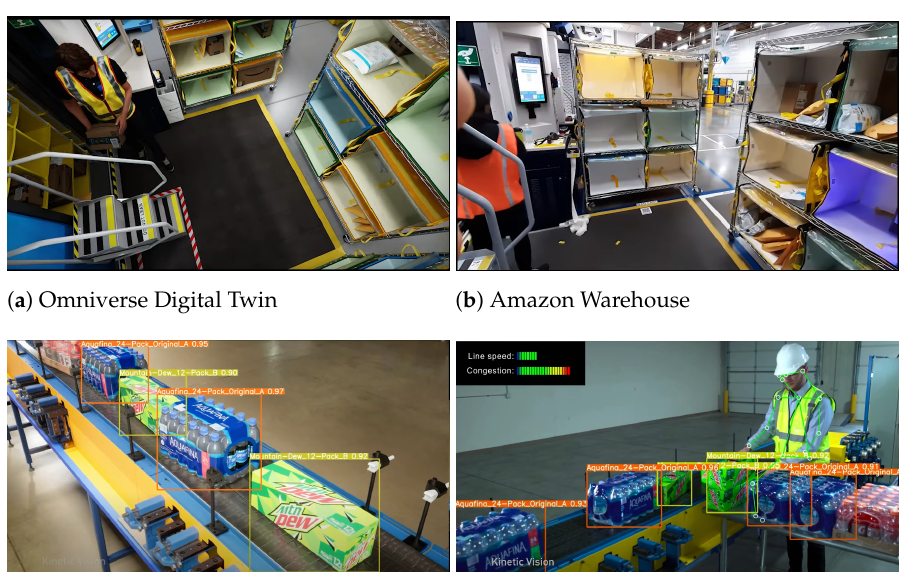
Figure 8. Nvidia Omniverse based DTs for Amazon and Pepsi